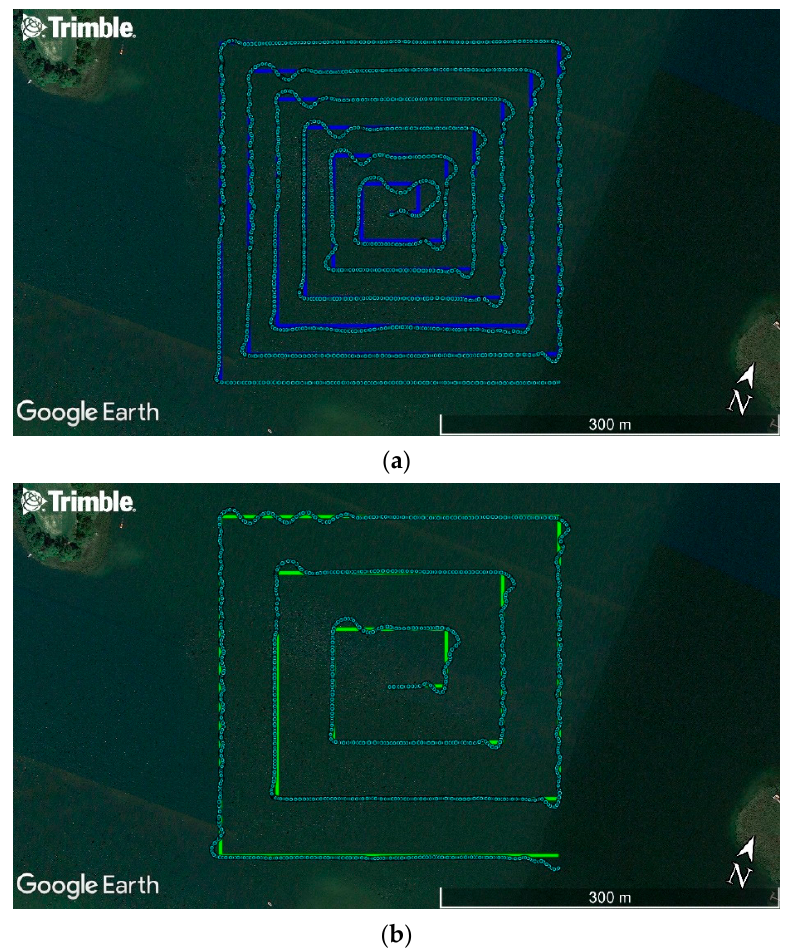
Figure 5. Arrangement of the route’s sounding profiles—spiral every ( a ) 25 m and ( b ) 50 m, on which the ASV/USV moved during the hydrographic surveys. The “HydroDron” vessel’s trajectory was marked with a sky-blue colour.